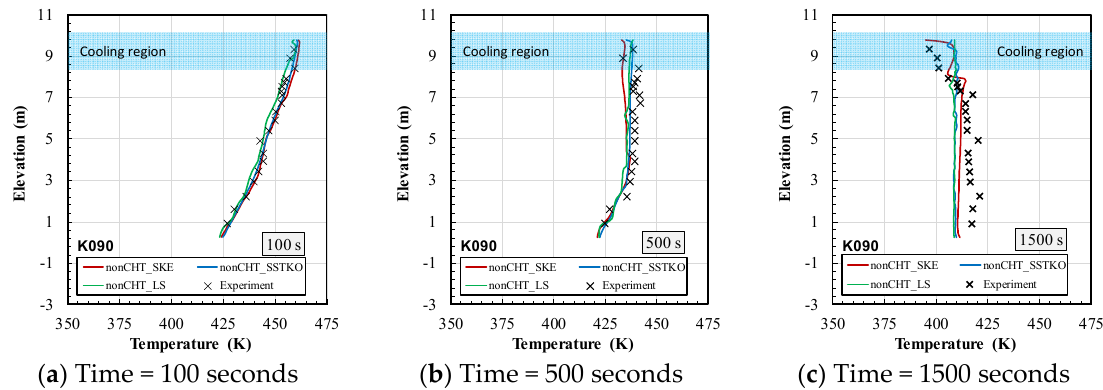
Figure 8. Comparison of the measured and numerically predicted temperature profile at K090.